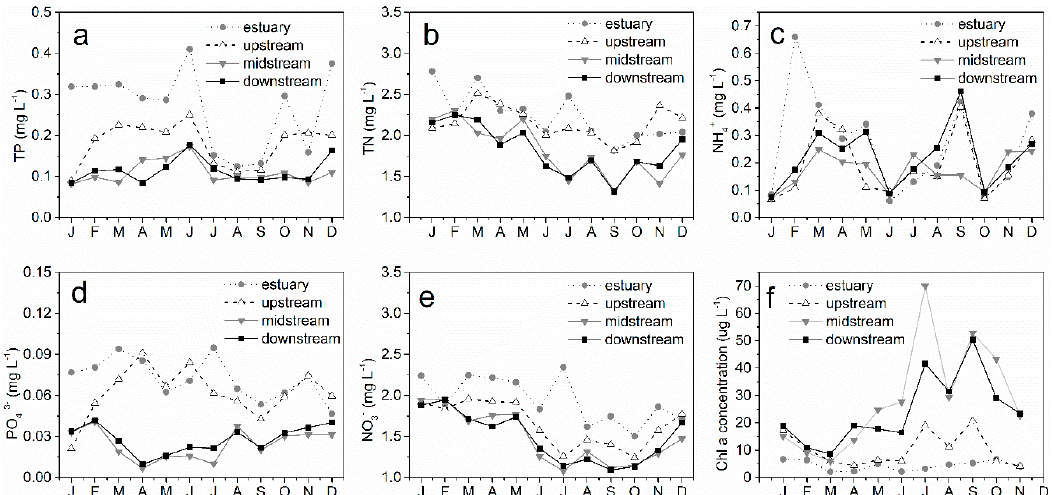
Figure 2. Seasonal variation of main environmental factors in the estuary, and the upstream, midstream and downstream parts of the reservoir. ( a ) Total Phosphorus (TP); ( b ) Total Nitrogen (TN); ( c ) Ammonia Nitrogen (NH 4 + ); ( d ) Soluble reactive phosphorus (PO 4 3 − ); ( e ) Nitrate (NO 3 − ); ( f ) Chlorophyll a (Chl a).